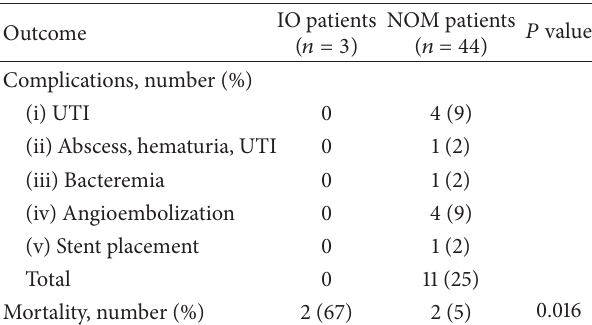
Table 2: Short-term outcomes in IO versus NOM patients.